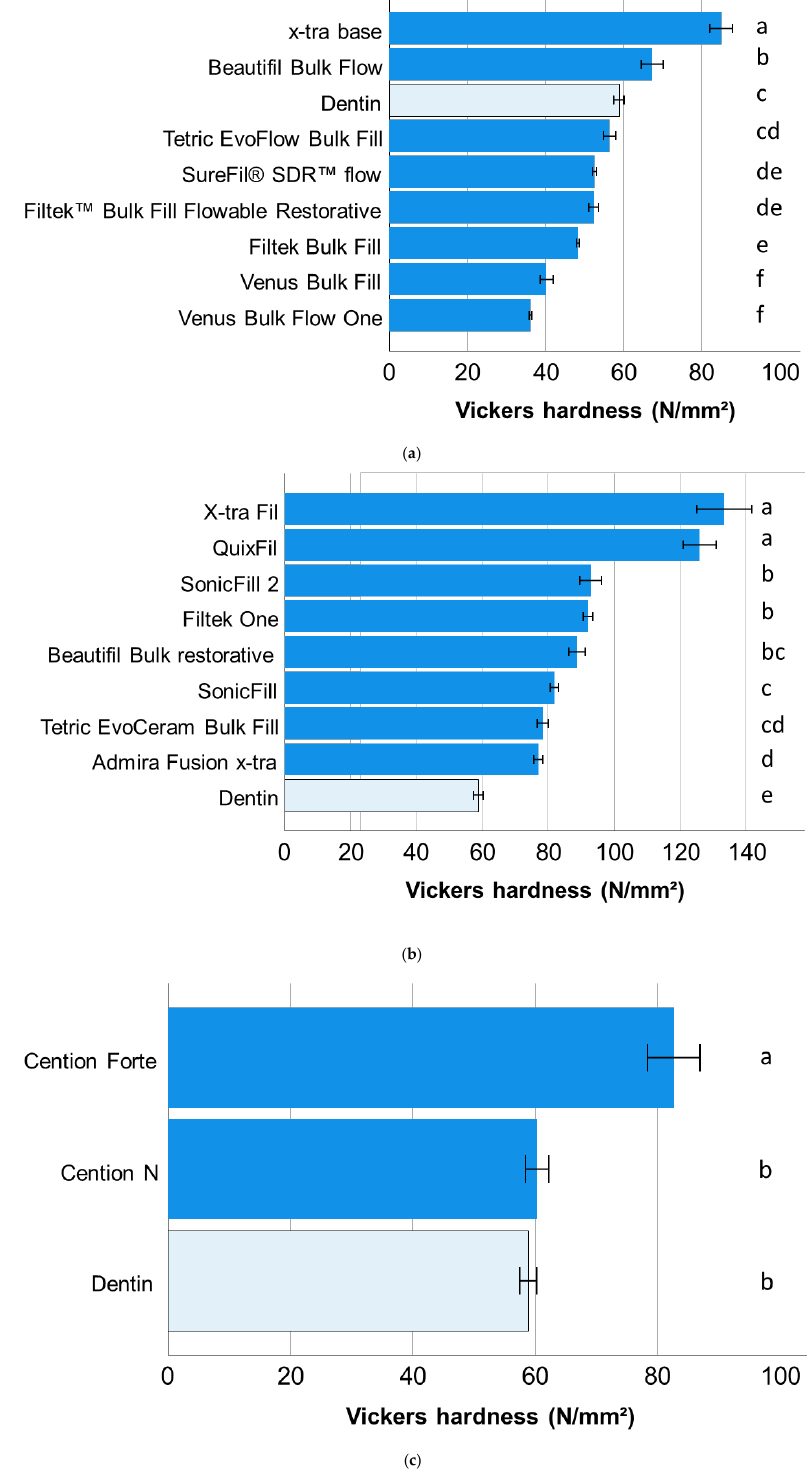
Figure 2. Vickers hardness (means with 95% confidence interval) as a function of RBC and bulk-fill category: ( a ) light-cured, low-viscosity bulk-fill RBCs; ( b ) light-cured, high-viscosity bulk-fill RBCs; and ( c ) dual-cured bulk-fill RBCs. Letters indicate homogeneous groups within each material cate- gory; Tukey’s post - hoc test (α = 0.05). The statistical analysis is somewhat similar for the Vickers hardness, while dentin has similar HV values as Filtek Supreme XT flow and Tetric EvoFlow bulk-fill in the light- cured low-viscosity bulk-fill RBCs (Figure 2a) and lower values than all analyzed high- viscosity bulk-fill RBCs (Figure 2b). For dual-cured bulk-fill RBCs, the ranking was similar to that for HM (Figure 2c). A completely different situation was observed for the indentation modulus. Dentin ranked highest among all light-cured low-viscosity bulk-fill RBCs (Figure 3a) and was surpassed only by X-tra Fil and QuixFil among the high-viscosity bulk-fill RBCs (Figure 3b). Cention Forte still outperformed Cention N in dual-cured bulk-fill RBCs, however, both had a lower indentation modulus compared to dentin (Figure 3c).